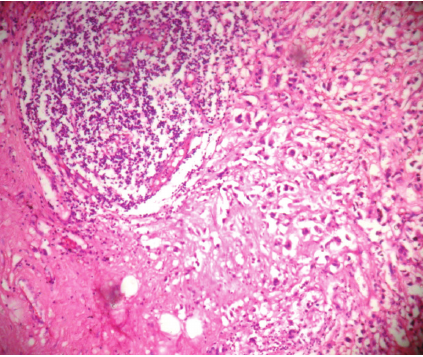
Figure 3: Cases of pPR showing inflammatory reaction (H&E × 400).